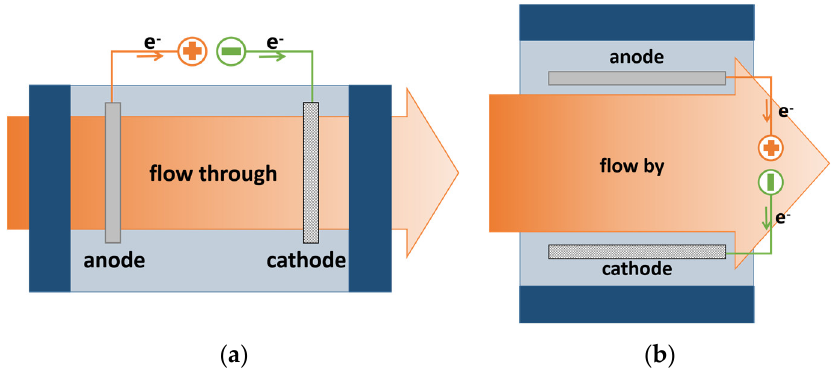
Figure 5. Schematic diagram of flow-through ( a ) and flow-by ( b ) mode of